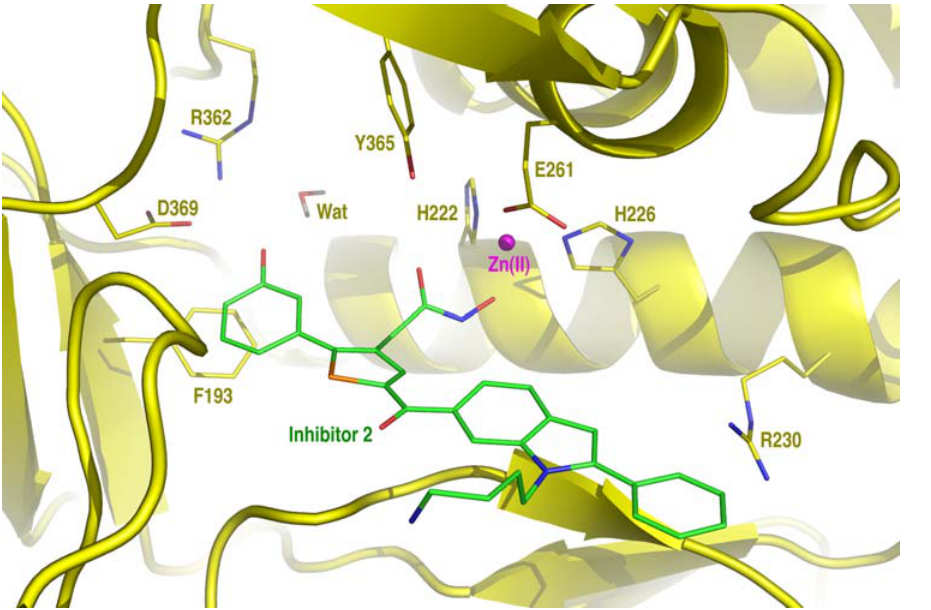
Figure 2. A close-up view of inhibitor 2 binding at the active site of the botulinum neurotoxin serotype A endopeptidase. The 3D model was generated by averaging 10,000 instantaneous structures obtained at 1.0-ps intervals during the last 0.5-ns period of 20 molecular dynamics simulations (2.0 ns for each simulation with a 1.0-fs time step and a unique seed for initial velocities) followed by 200 steps of energy minimization of the average structure of the entire